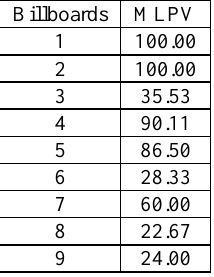
Table 3. Mean Logo Percent Visibility